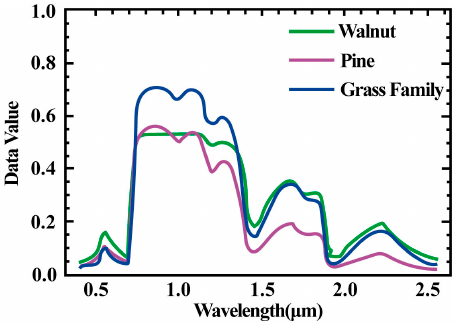
Figure 16. Spectral curves of features (note: these spectral curves of features are from the spectral libraries of ENVI 4.8).